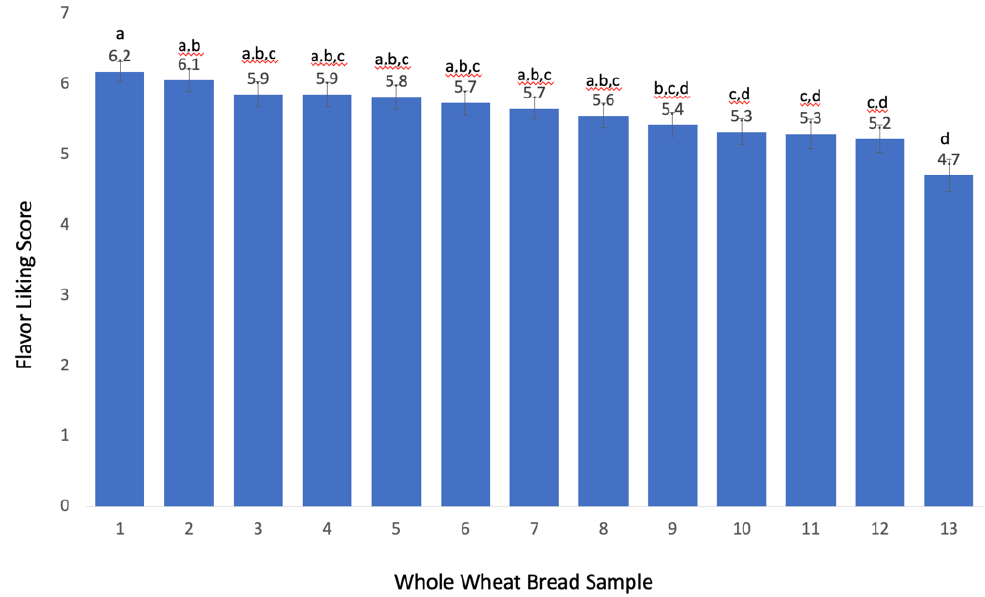
Figure 2. Average consumer flavor liking scores ( n = 97) and standard errors of whole wheat bread samples made with aged flour; different letters are significantly different ( p -value < 0.05) according to Tukey’s HSD .